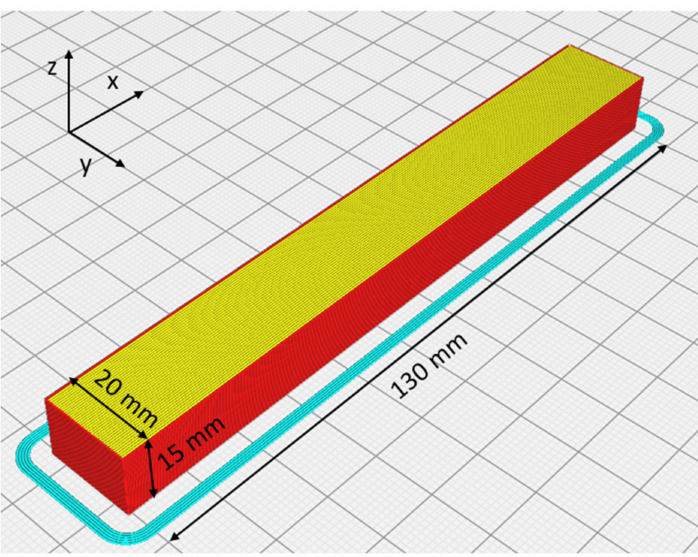
Figure 2. Dimensions of the specimen at the end of the slicing process in